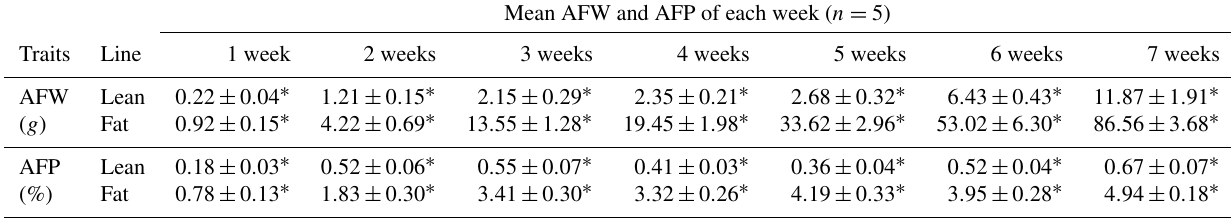
Table 2. AFW and AFP in lean and fat lines of NEAUHLF.